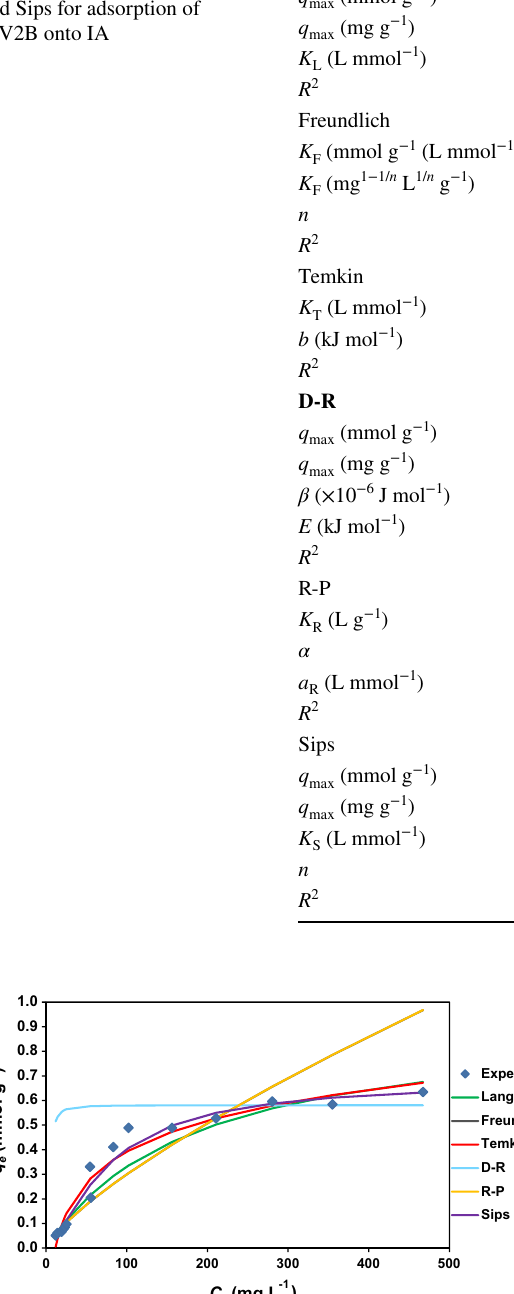
Applied Water Science (2020) 10:243 Table 3 The linear regression coefficients ( R 2 ) and isotherm parameters of Langmuir, Freundlich, Temkin, D-R, R-P and Sips for adsorption of MV2B onto IA